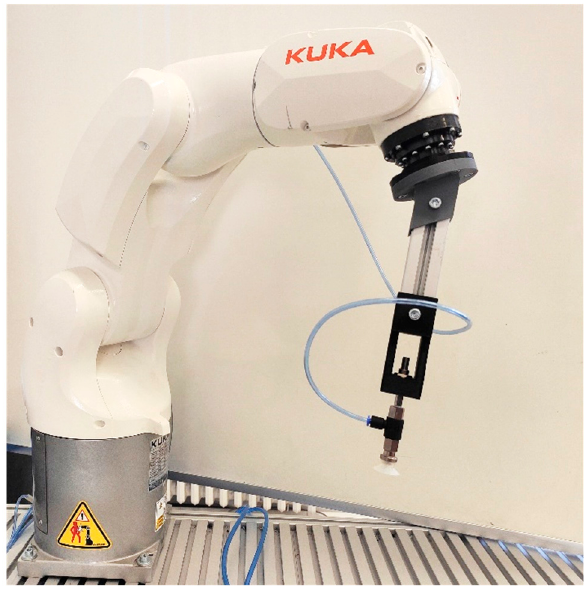
Figure 3. Robot range extension using flange.